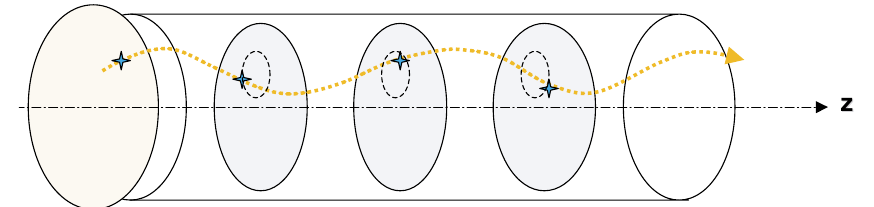
FIG. 46. (Color) Conceptual layout of MICE upstream spectrometer: following an initial TOF measurement, muons are tracked using detector planes located within a solenoidal magnetic field. Although in principle three x; y measurements as shown suffice to determine the parameters of each muon’s helical trajectory, in practice additional measurement redundancy will be employed; for example, a fourth measurement plane can be used to eliminate very-low-momentum muons that would execute multiple cycles of helical motion. A similar spectrometer (but with the time-of-flight measurement at the end) will be used downstream of the cooling